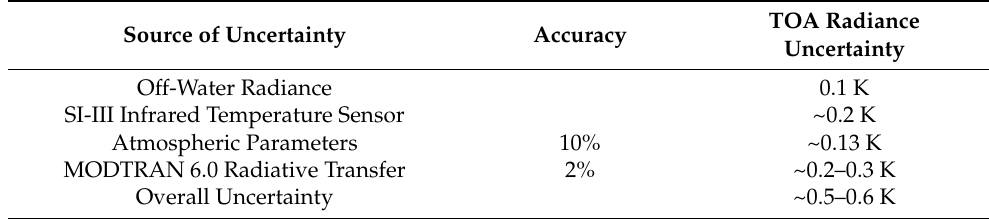
Table 5. Sources of uncertainty in TOA radiance of ZY1-02E vicarious radiometric